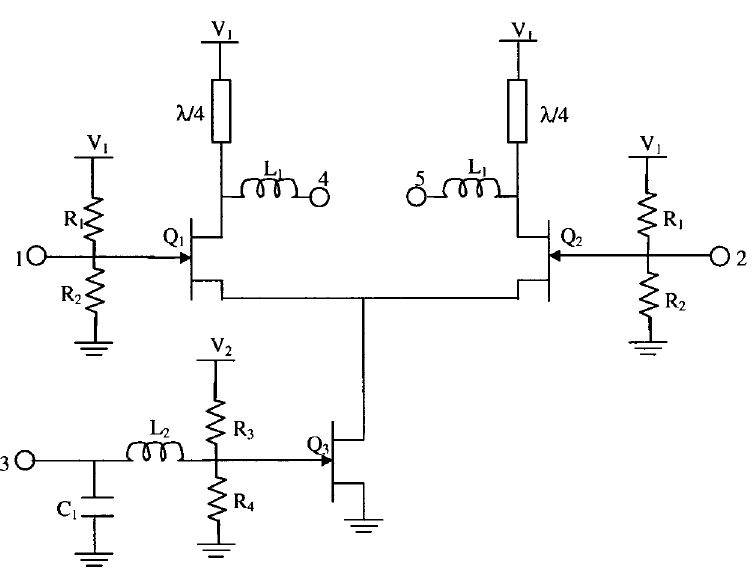
FIGURE 17 DC biased and matched active part of the BPSK modulator.